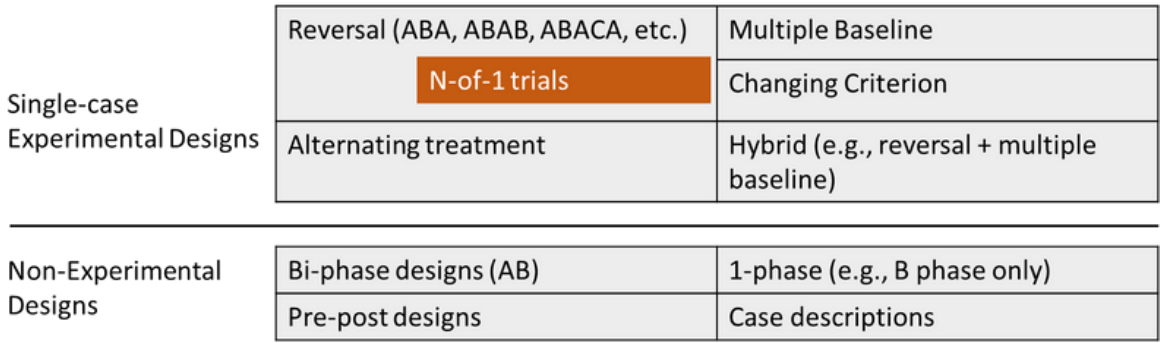
Figure 1. The main family of single-case experimental designs and nonexperimental designs. A = Baseline, B and C refer to different